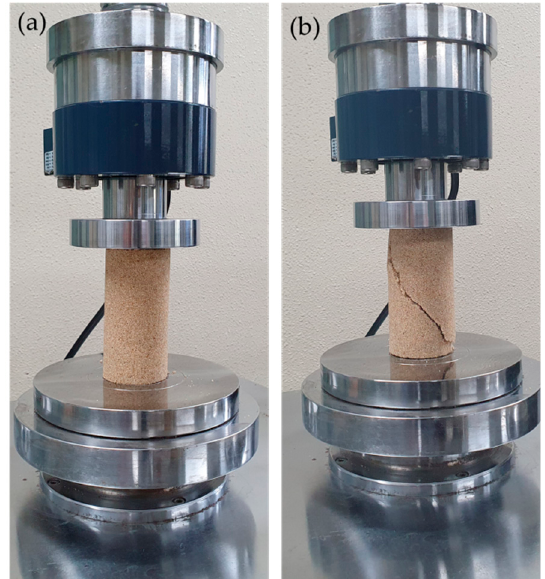
Figure 4. ( a ) Sample under unconfined compression and ( b ) sample failure mode.